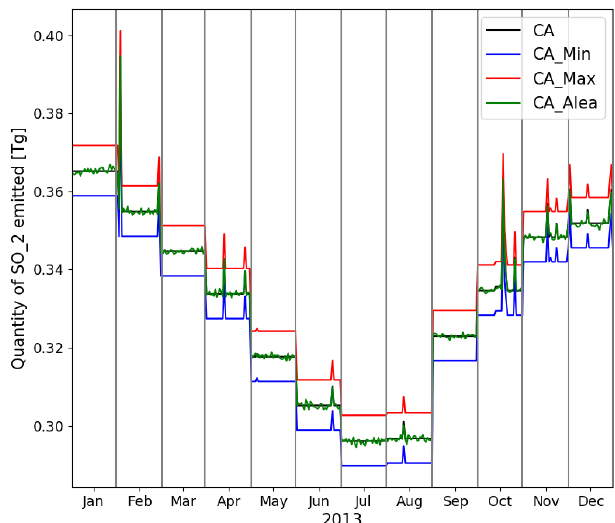
Figure 13. Temporal evolution of 2013 SO 2 emissions, corre- sponding to CA (black), CA_MIN (blue), CA_MAX (red) and CA_RAND (green)